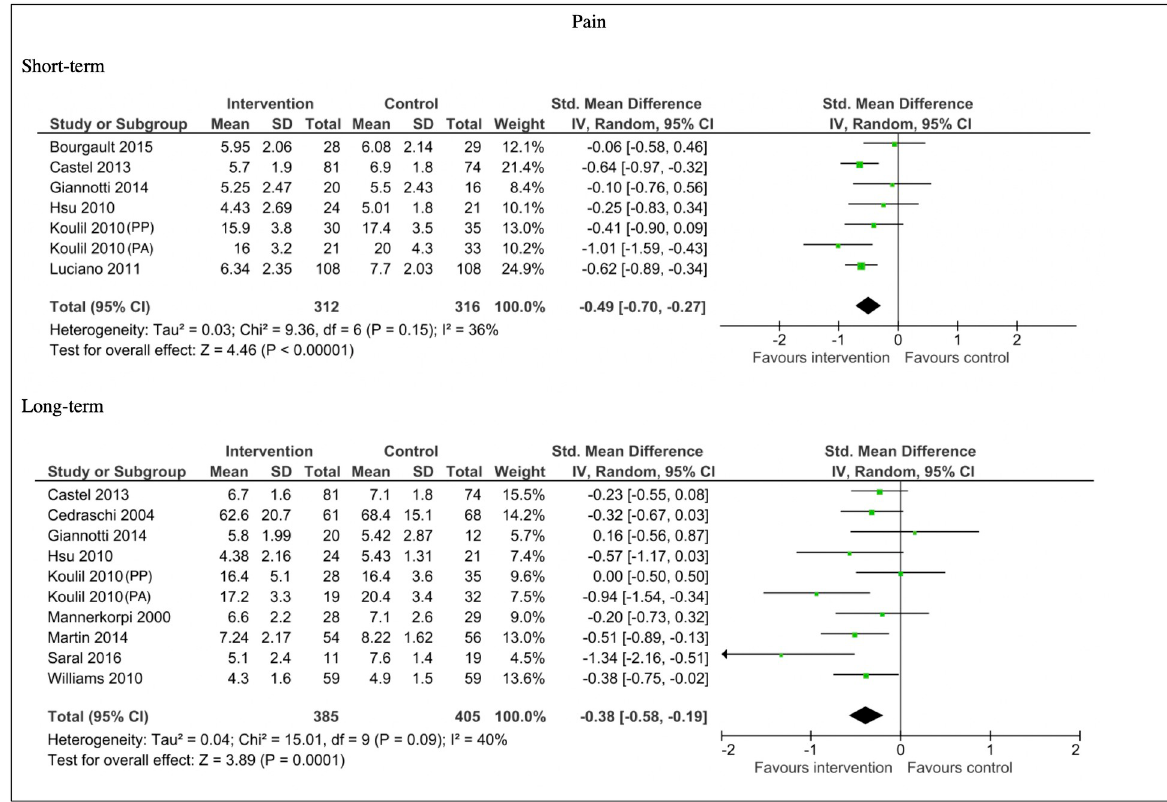
Fig 5. Forest plots of comparisons for pain measures for intervention compared to waitlist/no treatment/usual care controls.